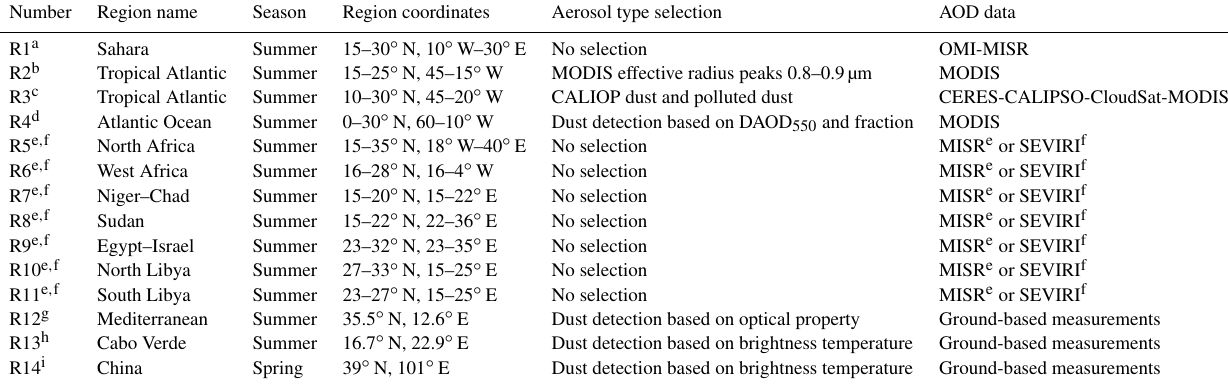
Table 4. Semi-observationally based data set of clear-sky dust radiative effect efficiency at the surface and